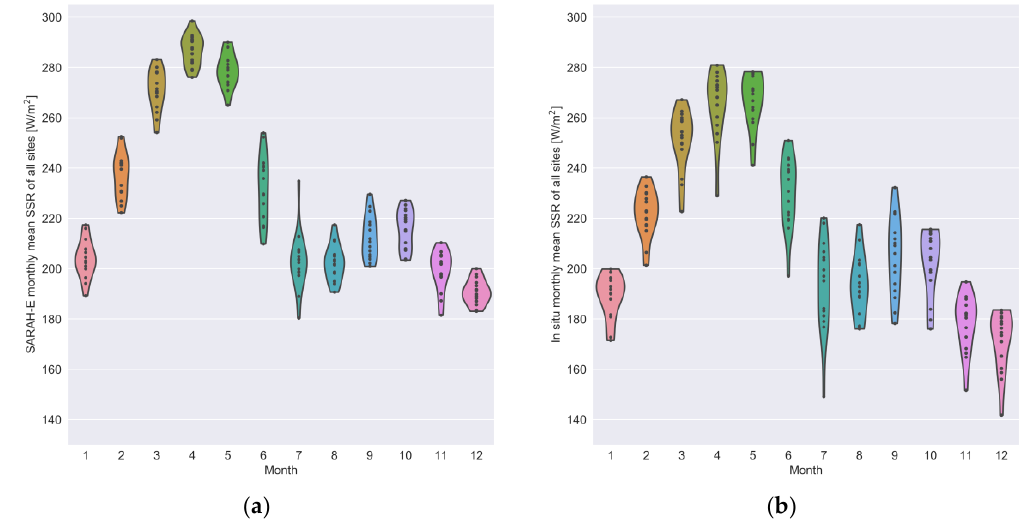
Figure 4. Monthly mean SSR over all validation sites between 1999 and 2014 from: ( a ) SARAH-E; and ( b ) in situ measurements. Violin plots indicate the kernel density estimates for each month, cropped to data extents. Markers within represent the SSR of the different years in the period. While the differences post-2009 are clear, this comparison alone does not reveal if the increasing